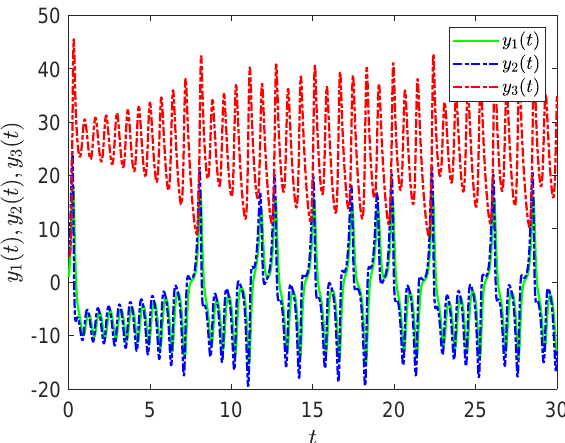
Figure 16. Plots of the solutions of y 1 , y 2 , y 3 .